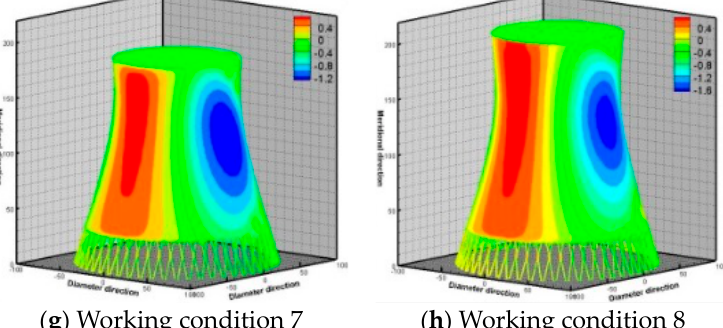
Figure 5. Nephograms of pressure coefficients on tower surface under eight typical working conditions.